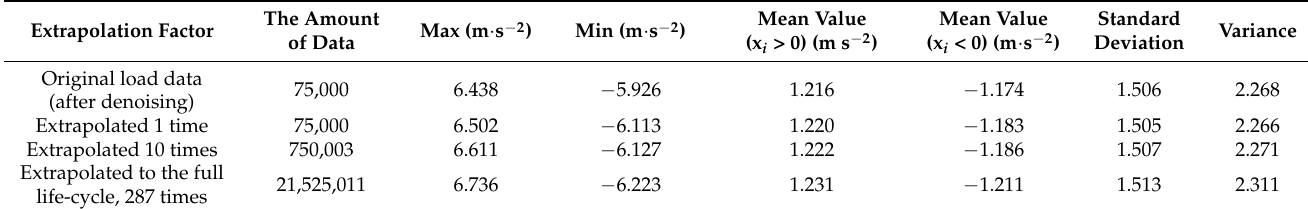
Table 7. Statistical characteristics of extrapolated data of rear axle (right) load during